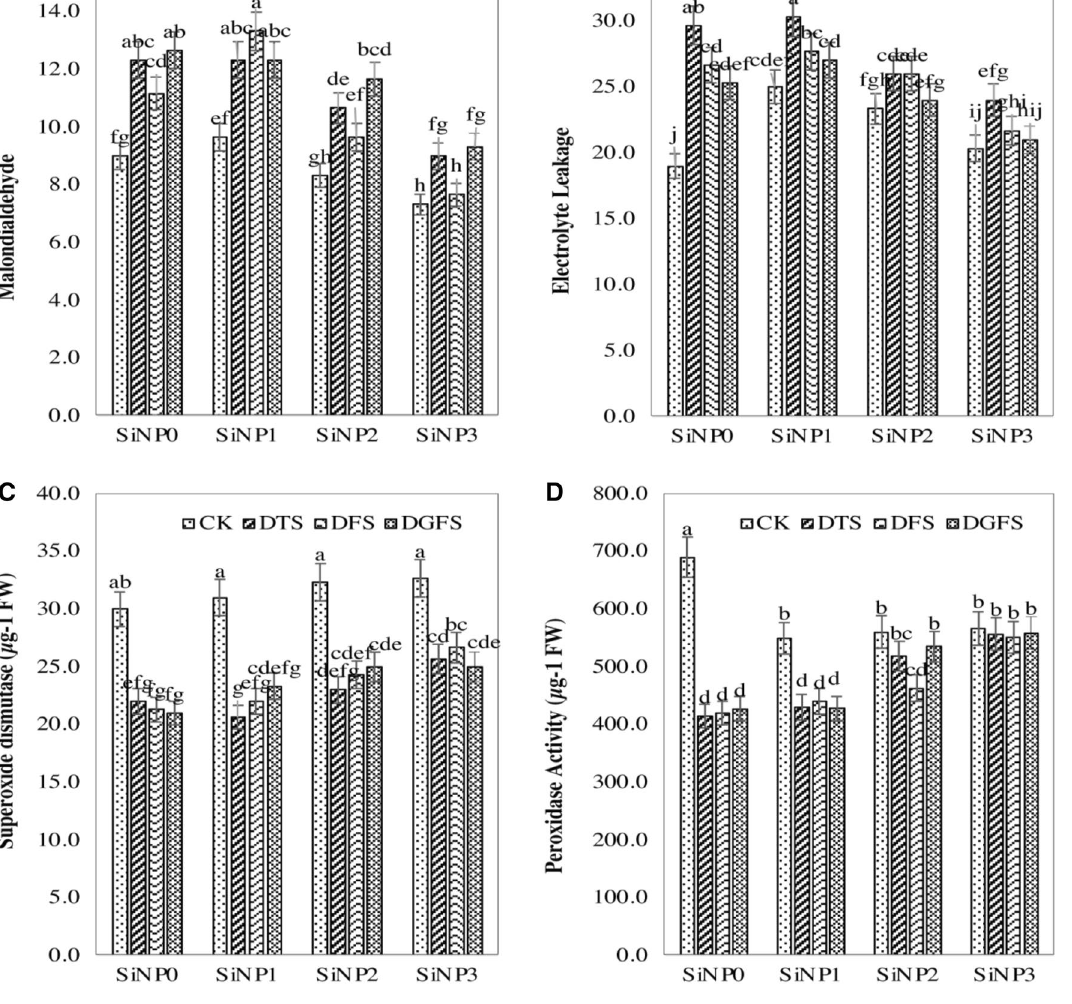
Figure 4. Effects of Si-NPs (0, 300, 600 and 900 mg/L) under drought stress on MDA (A) , EL% (B), SOD (C) and POD (D) . Critical growth stages of wheat were ( CK Control, DTS drought at tillering stage, DFS Drought at the flowering stage, and DGFS Drought at the grain filling stage) of